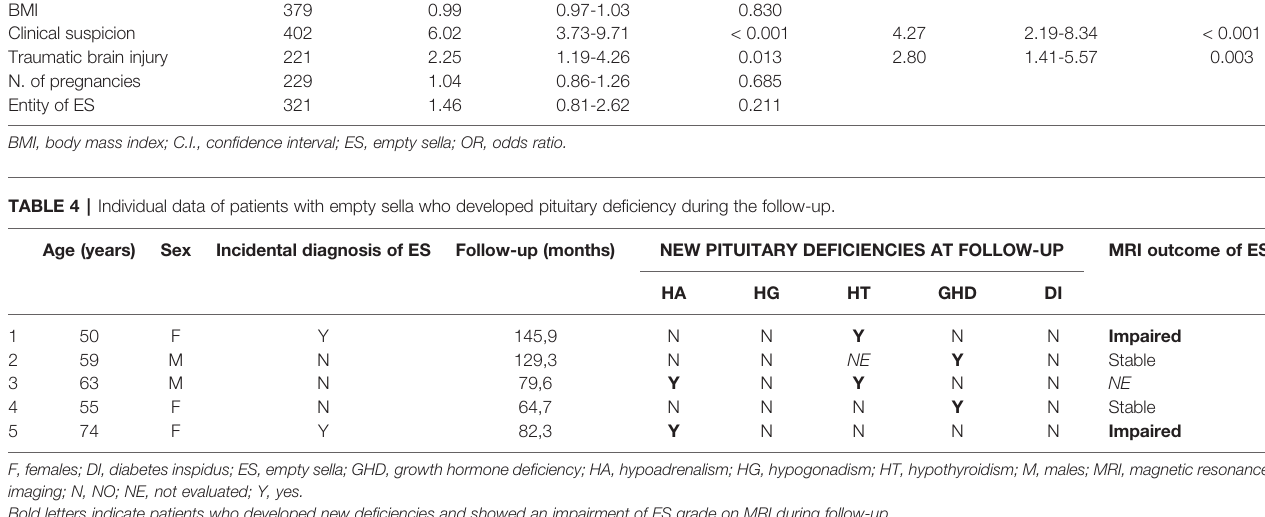
TABLE 5 | Individual data of patients with empty sella who recovered pituitary function during the follow-up. Incidental diagnosis of ES Follow-up (months) RECOVERY OF PITUITARY FUNCTION DURING THE FOLLOW-UP